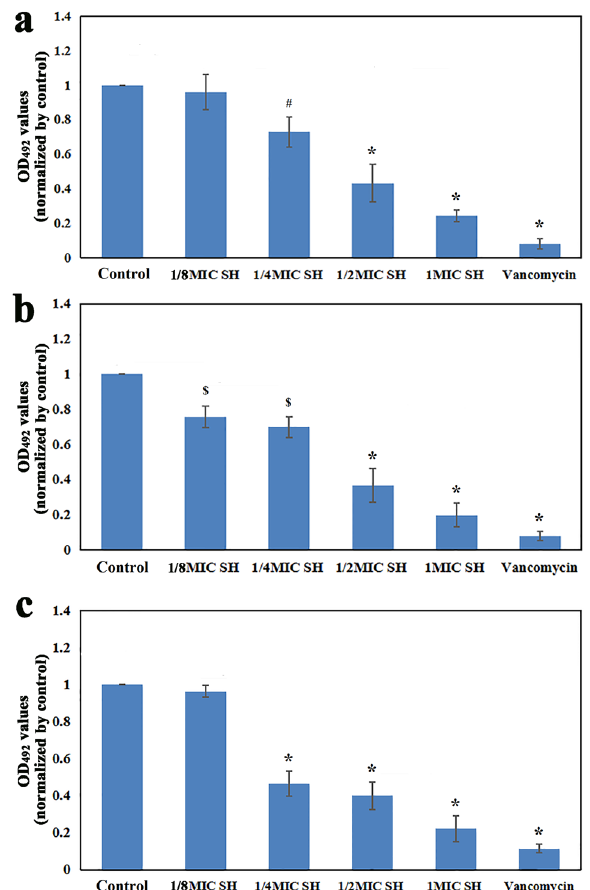
Figure 3. CV staining of bacterial biofilms under different culture conditions. Compared with the control and 1/8MIC SH groups, * P < 0.01. Compared with the control group, # P < 0.05. ( a ) S. epidermidis ATCC 35984. ( b ) S. aureus ATCC 43300. ( c ) MRSE